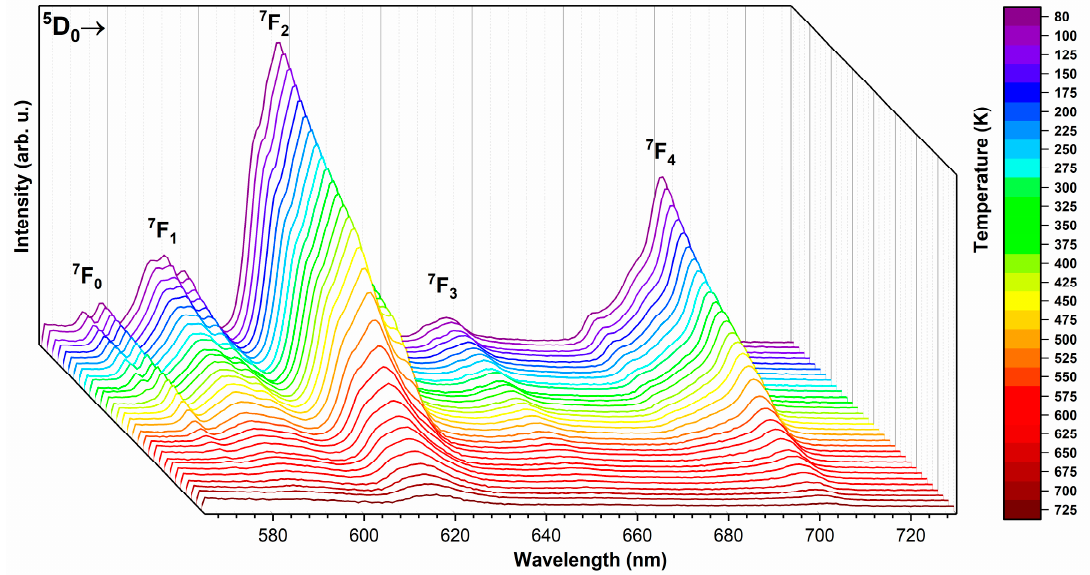
Figure 7. Temperature-dependent emission spectra of the Ca 9.6 Sr 0.2 Eu 0.2 (PO 4 ) 2 (SiO 4 ) 4 (OH) 2 , sintered at 600 °C.